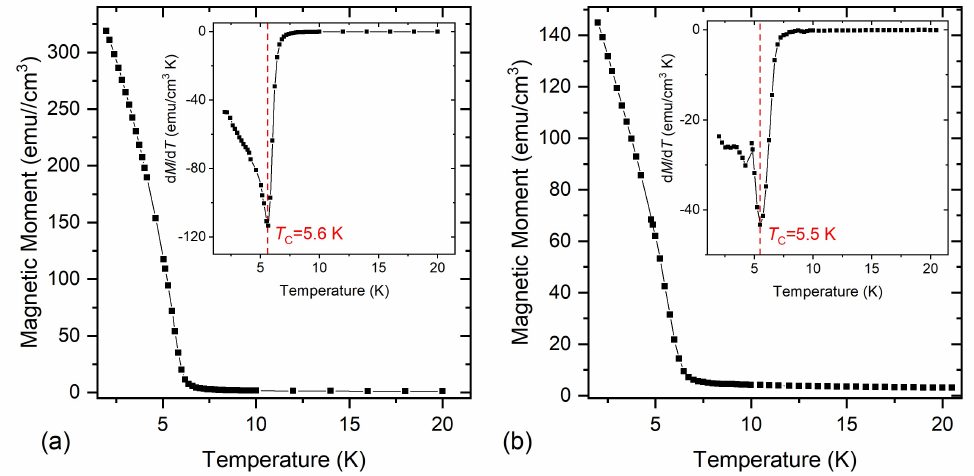
Figure 3. ( a ) The 20 Oe FC M vs. T measurement for Si/SiO 2 /Eu 3 O 4 /Au. The inset presents the d M /d T vs. T plot used to determine the T C . ( b ) The ZFC M vs. T measurement for the Si/SiO 2 /graphene/Eu 3 O 4 /Au sample. The inset shows the d M /d T vs. T graph used to deduce the T C of the Eu 3 O 4